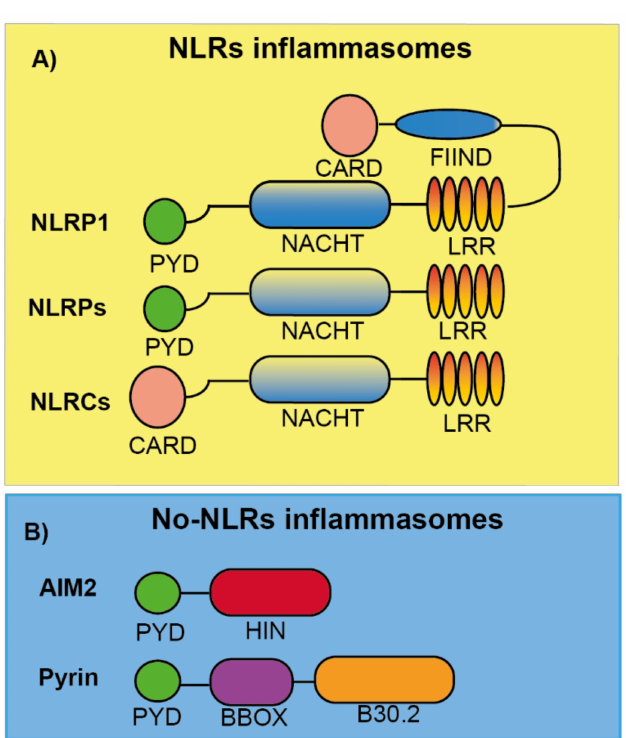
Figure 1. Schematic representation of the different inflammasome sensor proteins. ( A ) Nod like receptor (NLR) proteins are formed by either a PYD (NLRP) or CARD (NLRC) domain at the N- terminal position follow by a central domain (NACHT), responsible for NLR oligomerization, and a C-terminal leucine-rich repeat domain (LRR). For NLRP1, a FIIND and CARD domain are in the C-terminal position after the LRR domain. ( B ) AIM2 and Pyrin are no-NLR inflammasome sensors with a PYD domain at the N-terminal. AIM2 also presents a HIN domain responsible of DNA binding. Pyrin is also formed by a central coiled BBOX domain and a C-terminal B30.2/SPRY